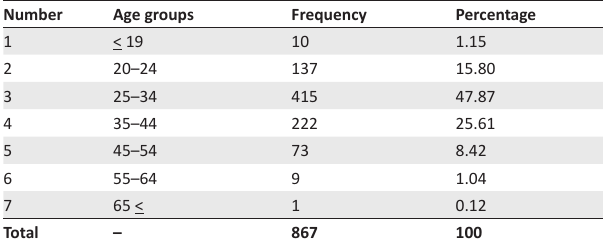
TABLE 3: Age distribution of participants. Number Age groups